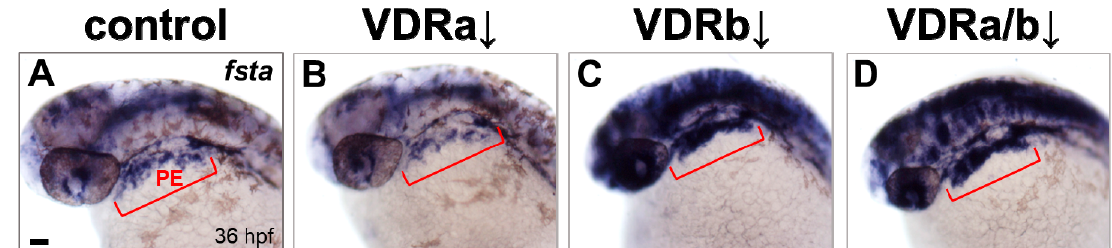
Figure 2. Expression of fsta in vdr morphants. ( A ) Wild-type control. ( B ) vdra morphant. ( C ) vdrb morphant. ( D ) vdra/b morphant. Expression of fsta in pharyngeal arches is upregulated in vdrb and vdra/b morphants. Upregulation throughout much of the brain, eye, and anterior spinal cord was also noticed in the embryos lacking vdrb . Images show dorsolateral views with anterior to the left at 36 hours post-fertilization (hpf). Red brackets indicate the domain of pharyngeal endoderm (PE). Scale bars = 50 μ m.